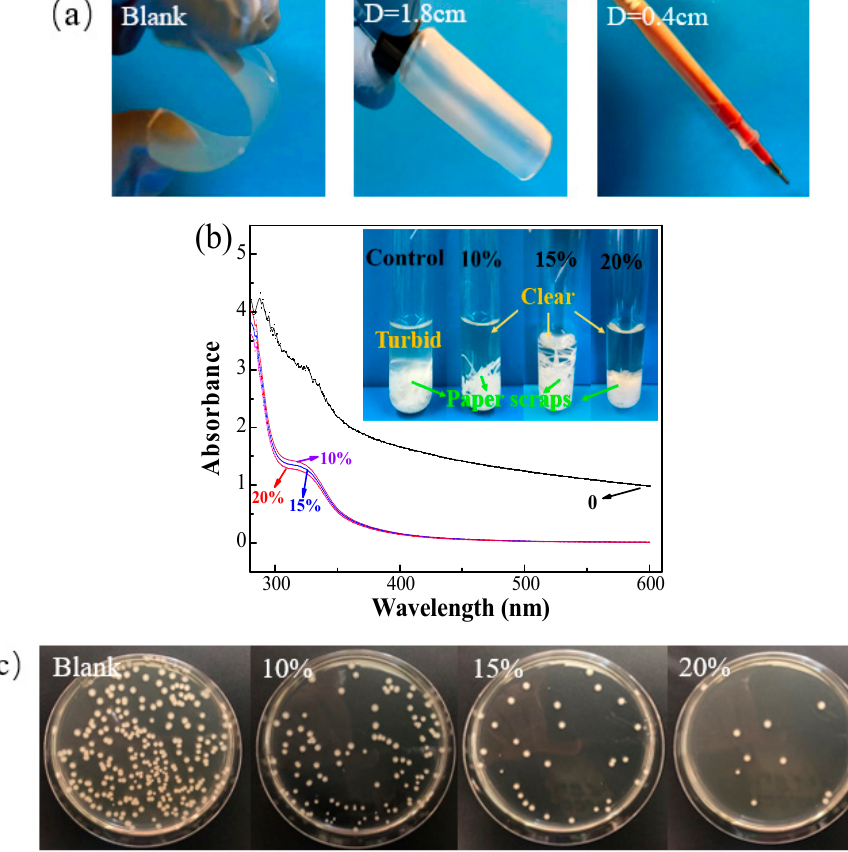
Figure 9. ( a ) Mechanical flexibility of the starch composite film before (blank) and after the addition of 2% CMC (D = 1.8 cm), 2% CMC and 20% antimicrobial thermal plastic starch (ATPS) (D = 0.4 cm). D represents the bending diameter of the films. ( b ) UV–Vis absorbance showing the growth levels in the supernatant of blank and coated papers with various ATPS dosages. ( c ) Pictures of the antimicrobial activities of coated papers with various ATPS dosages against E. coli using a shaking flask method.